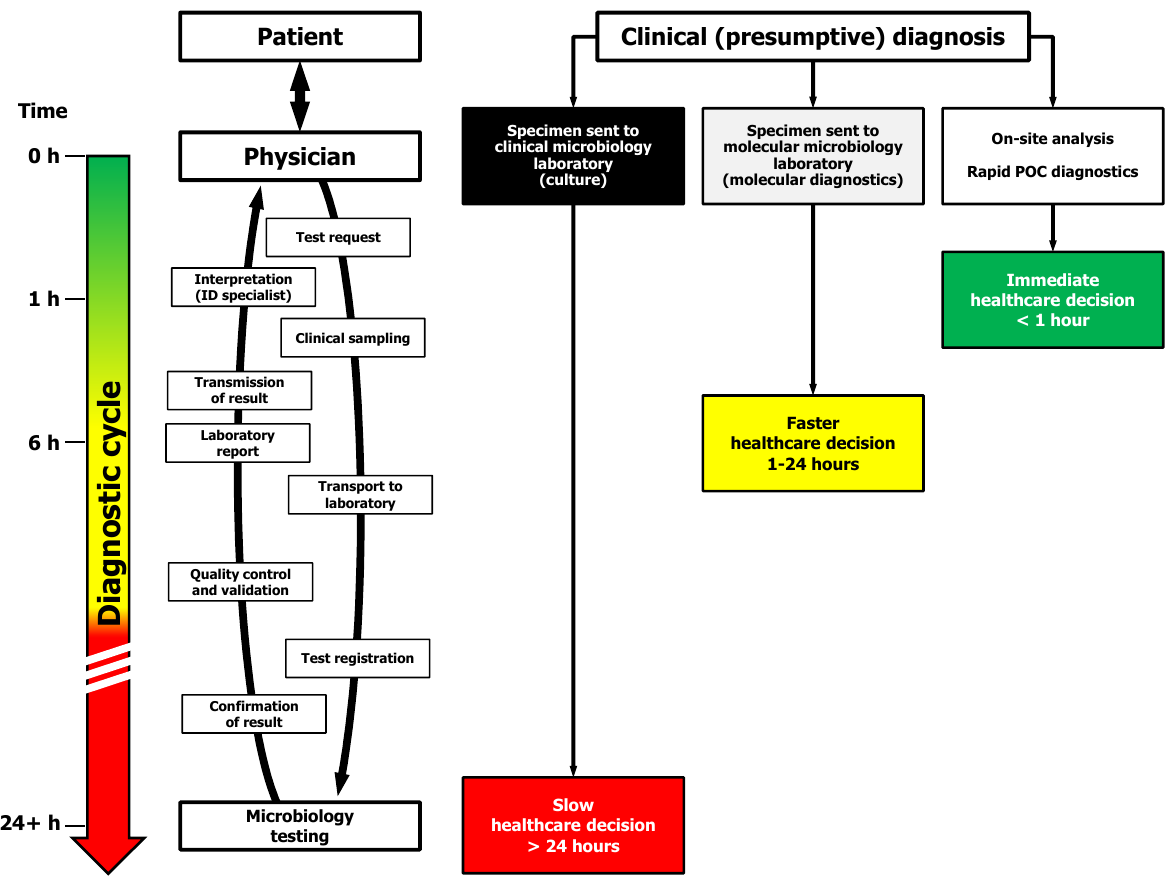
Figure 1. Personalized medicine in infectious disease management. The implementation of rapid point-of-care (POC) microbiology shall decrease the length of the diagnostic cycle in order to accelerate infectious disease